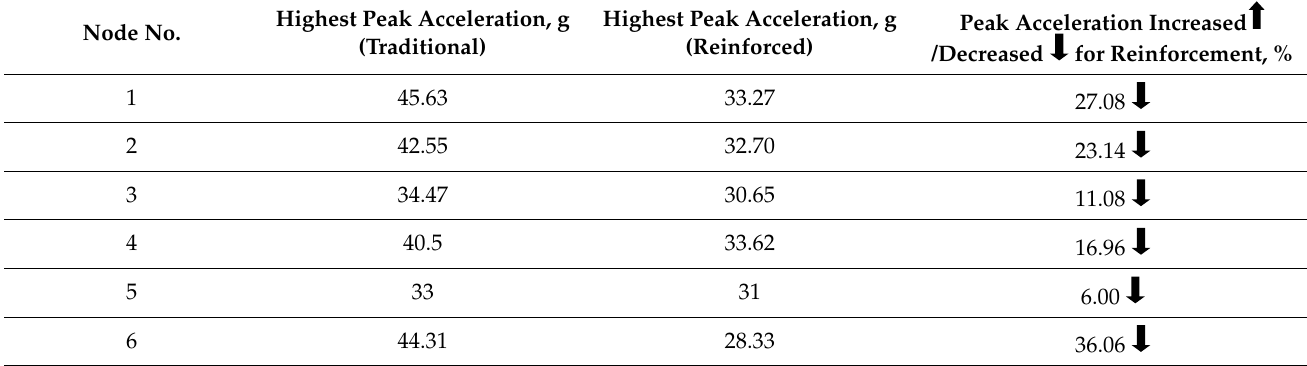
Table 5. Highest Peak Acceleration Responses.